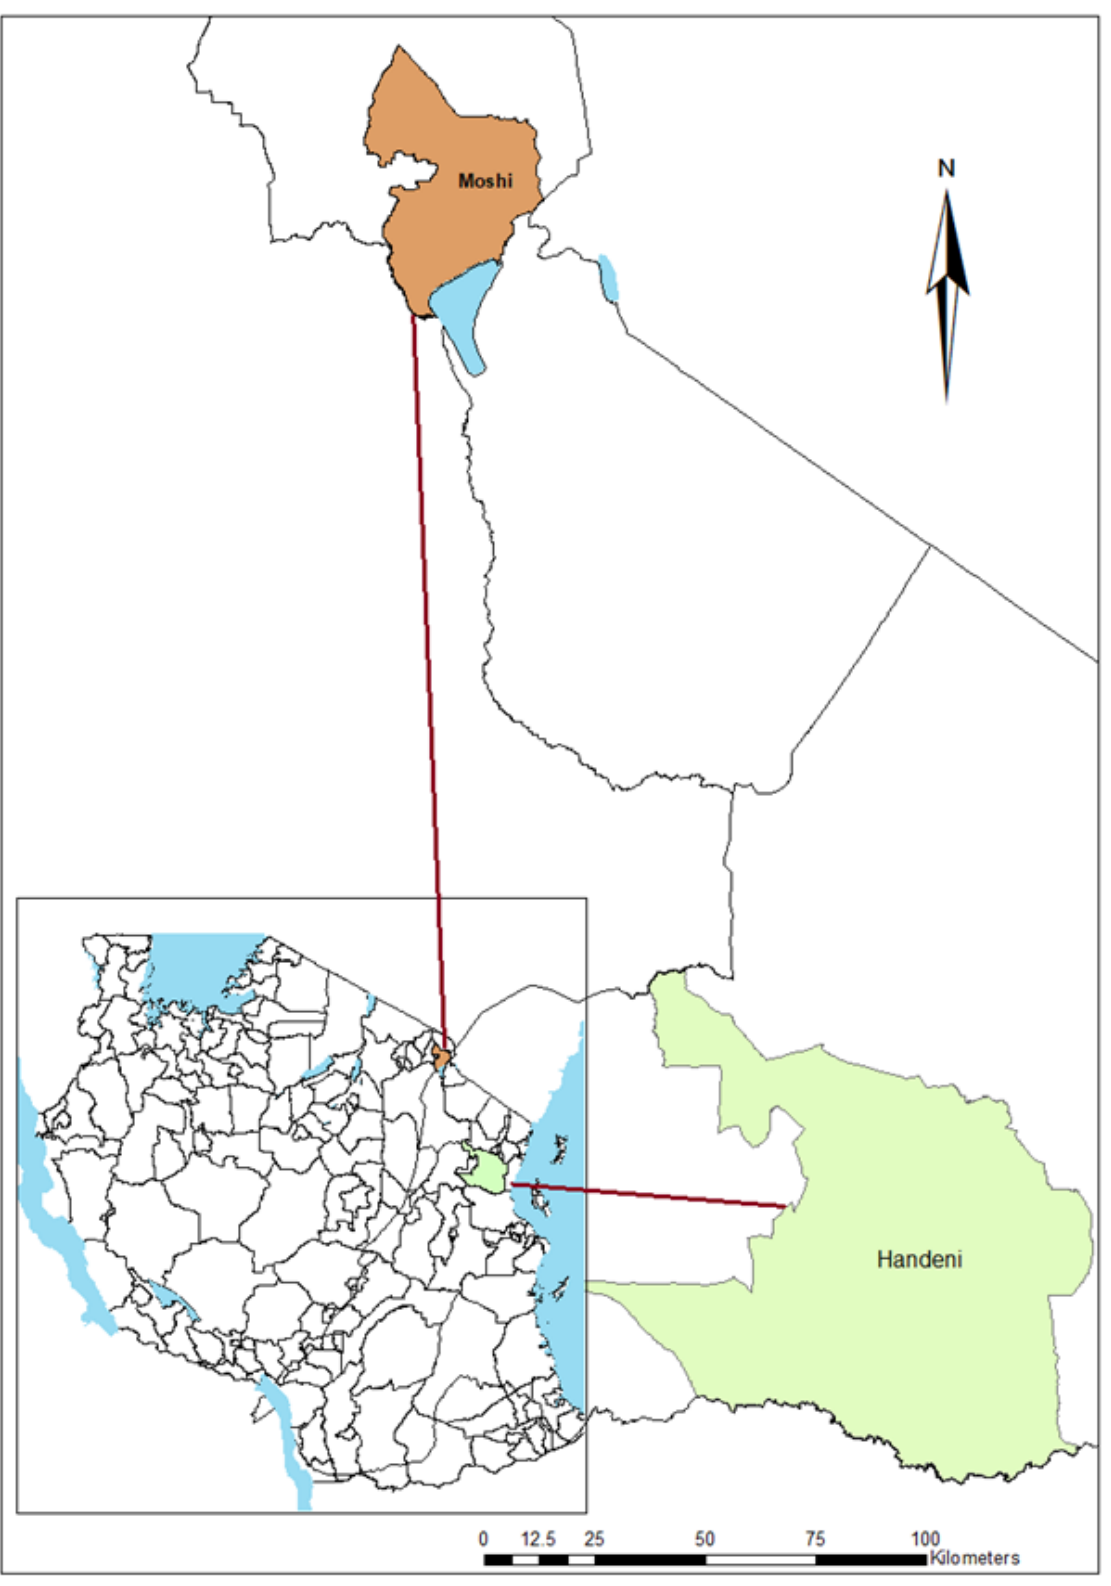
Figure 1. A map of Tanzania showing the study sites (map created using ArcGIS software v10.3).